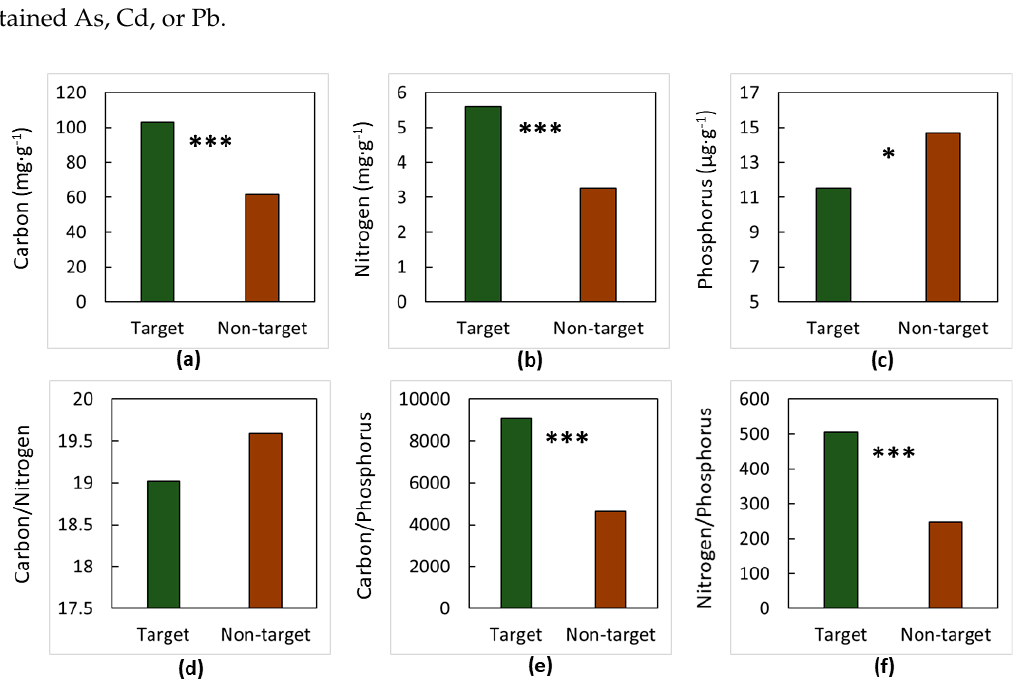
Figure 6. The influence of proximity to Cycas micronesica on soil chemical traits in schist soils on Yap. Target soils were collected underneath cycad trees. Non-target soils were collected 5-m from focal cycad trees. ( a ) Total carbon; ( b ) Total nitrogen; ( c ) Modified Truog phosphorus; ( d ) Carbon/nitrogen; ( e ) Carbon/phosphorus; and, ( f ) Nitrogen/phosphorus. *, **, *** = significant at 0.05, 0.01, or 0.001.